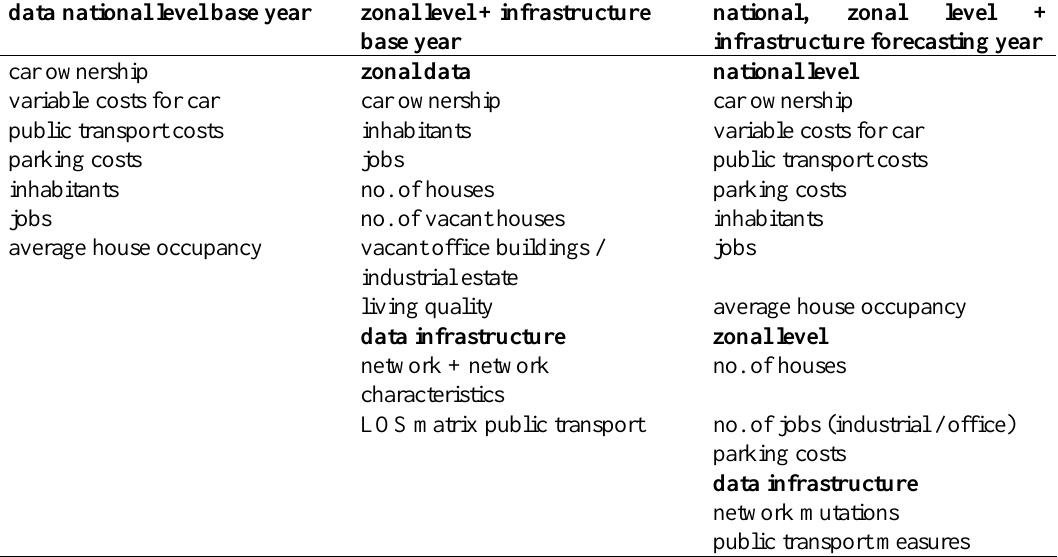
Table 1. Data needs for TIGRIS applications